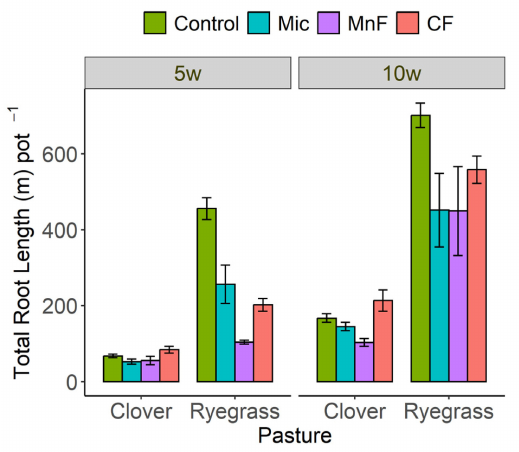
Figure 2. Root length (m pot − 1 ) for subterranean clover and annual ryegrass grown separately at 5 and 10 weeks. Treatments were untreated soil (control), rock mineral fertilizer (MF), chemical fertilizer (CF) and microbial inoculant (Mic). Results are presented as means + standard errors.